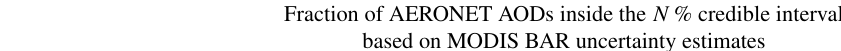
Table 8. Fraction of AERONET AODs inside 50, 80, 90, 95, and 99% credible intervals based on MODIS BAR uncertainty estimates. For comparison also MODIS DT expected error (EE) envelope-based results are shown corresponding to DT